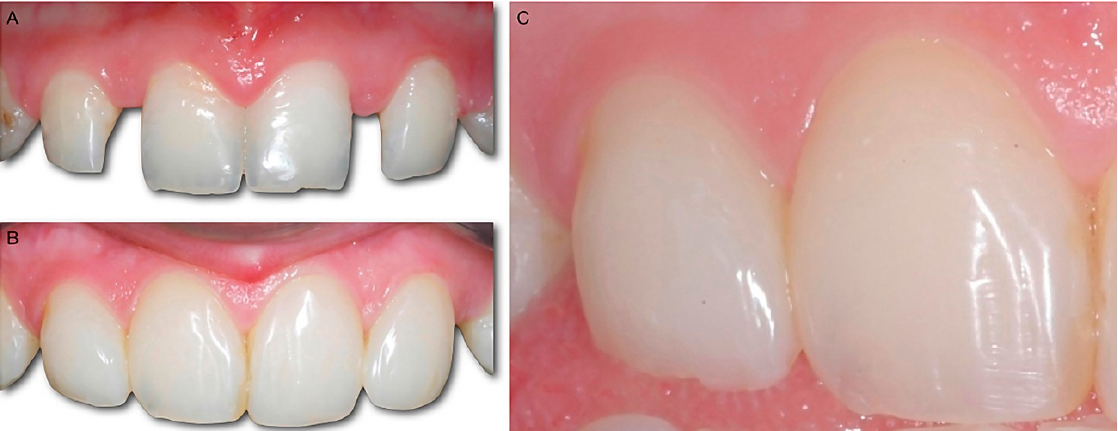
Figure 6. 20-year-old man at the end of orthodontic treatment. The frontal sector shows small teeth, and large diastemas ( A ). To meet the aesthetic needs of the patient, it was necessary to enlarge the teeth with intrasulcular restorations, and to recreate the contact points that allowed the papillae to close the unsightly black triangles ( B ). Although the patient does not maintain optimal oral hygiene, the gingival tissues are in excellent health ( C